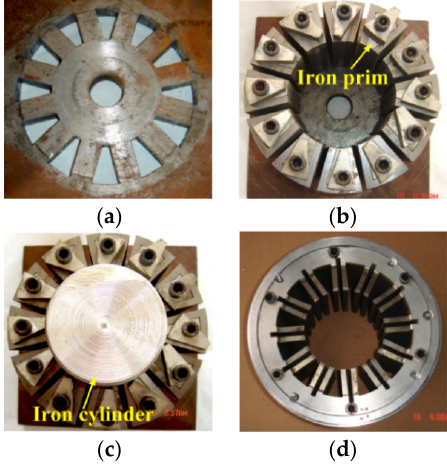
Figure 20. Mounting process of the C ‐ core stator laminations. ( a ) Assistant base; ( b ) Locating of laminations; ( c ) Concentricity of laminations; ( d ) Accomplished assembling of stator laminations and housing.